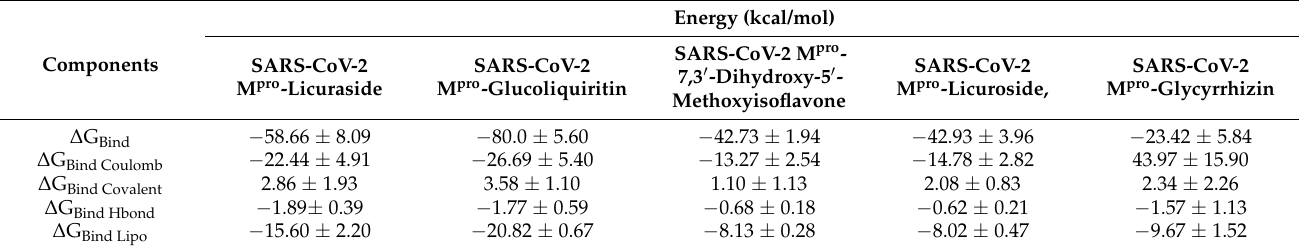
Table 3. Averaged binding free energies (kcal/mol) and energy dissociation components calculated using an MM/GBSA method for all the selected bioactive compounds and the reference compound docked with SARS-CoV-2 M pro .